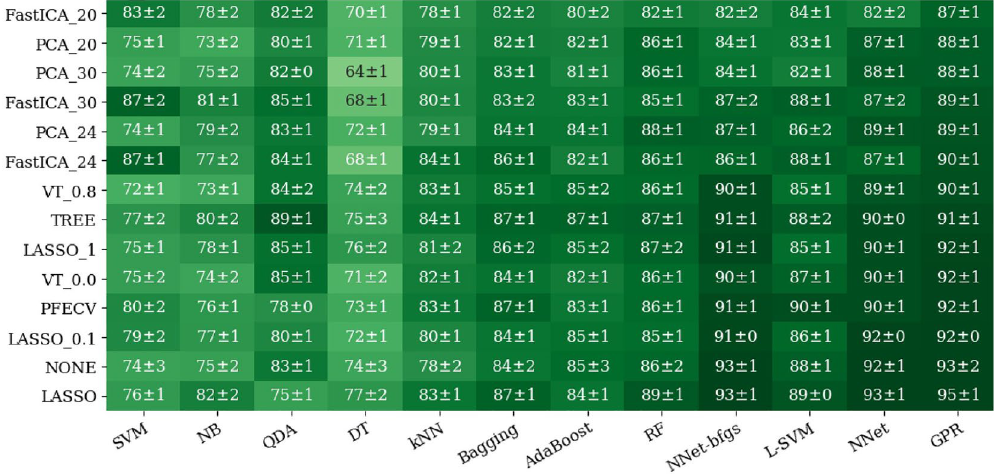
Figure 5. The AUC grid for different ML (x-axis) classifiers and FS methods (y-axis) combinations. The number in front of each PCA or FastICA method is the number of selected features used. The number in front of each LASSO method corresponds to the α penalty value (the default value is 0.5). The number in front of each VT method is its variance threshold value. Matplotlib (version 3.4.3) (https:// pypi. org/ proje ct/ matpl otlib/3. 4.3/) is used for visualizing the